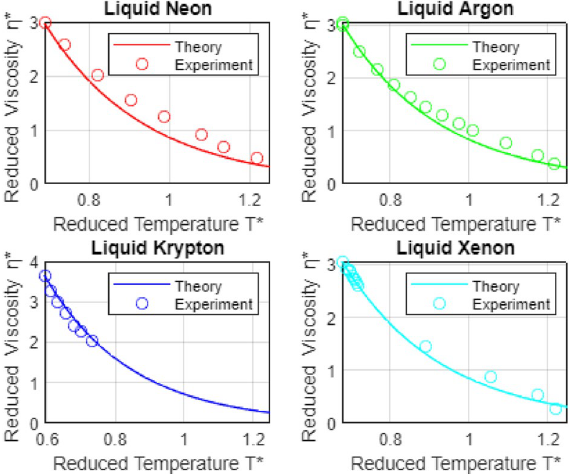
Figure 1. Temperature-dependent viscosity for noble liquids. The proposed model assumes: (i) dominant pairwise, dispersive, intermolecular interactions—see the scaling argument (i) in the final section, and (ii) that the average collision-induced distortion of the molecule’s electrons, δσ( T )